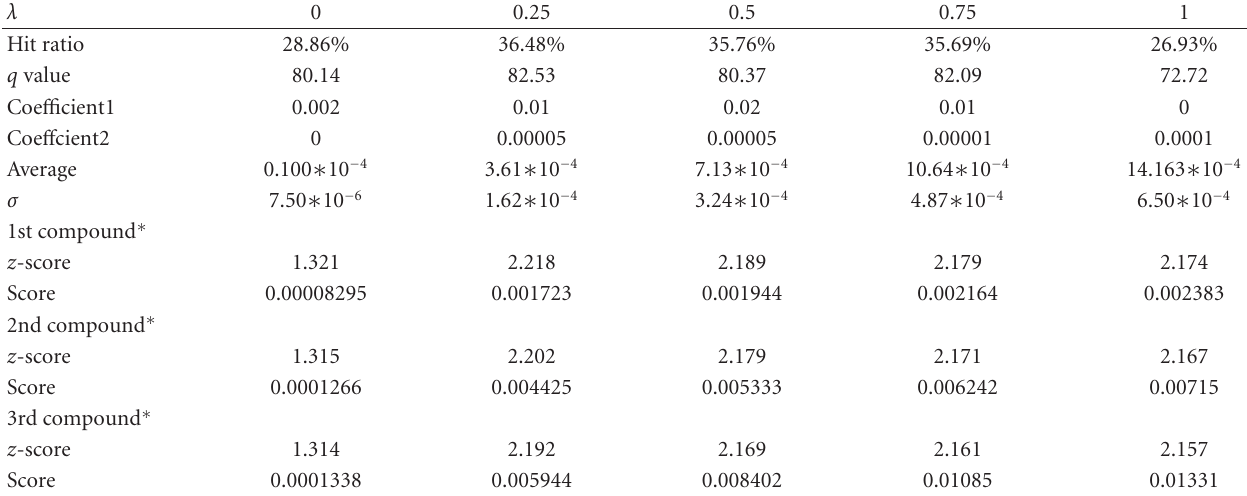
Table 1: The average q values and the hit ratio with optimized coe ffi cients for various λ values. The coe ffi cient1 is the c parameter in (4) for the E matrix and the coe ffi cient2 is the c parameter in (4) for the D matrix. The hit ratio is the % of the active compounds found within the first 1% of selected compounds of the database. The average and σ are the average value and the standard deviation of the scores. ∗ : the top-ranked compounds when diphenhydramine is the